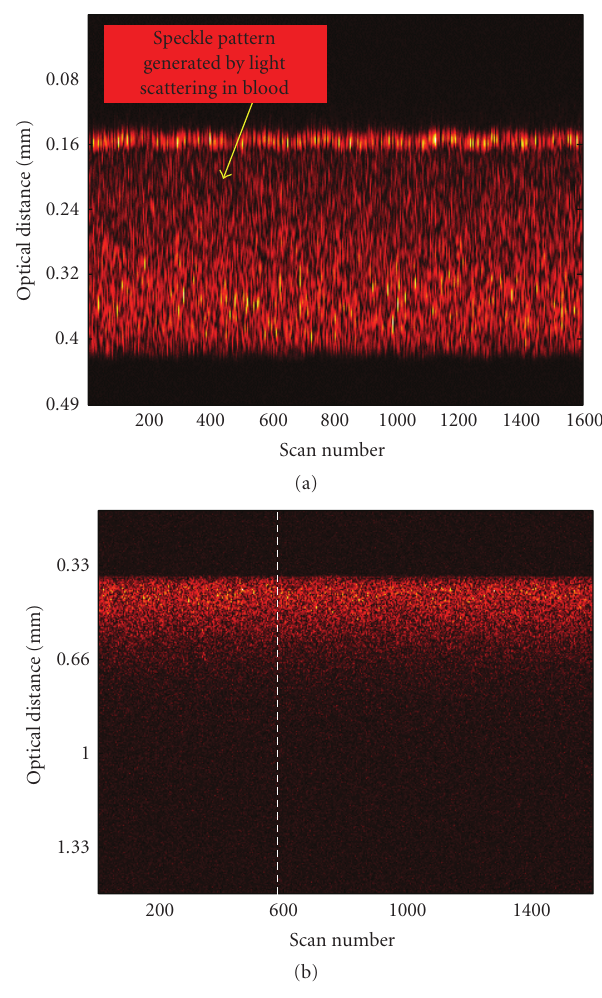
Figure 1: (a) OCT image of blood flowing through the 0.2-mm cell. Both blood/glass interfaces are visible. (b) OCT image of blood flowing through the 2-mm cell. The interrupted white line marks the 600th A-scan. Both images are composed of 1600